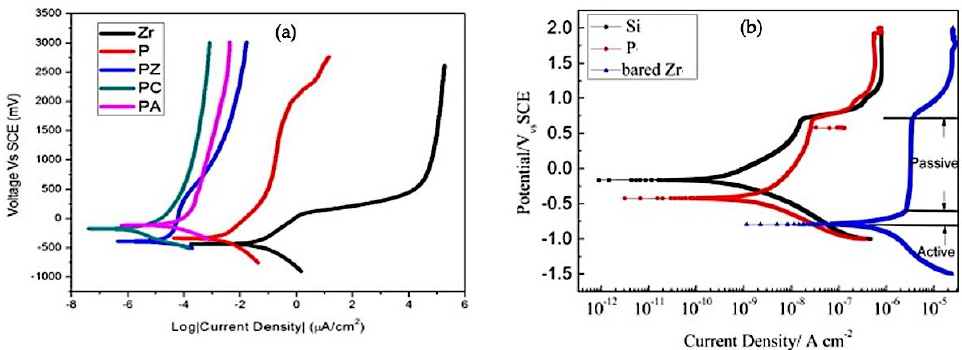
Figure 3. ( a ) PDP plot of Zr substrate, simple PEO coating (P), composite coating of PEO and each of Al 2 O 3 (PA), Ce 2 O 3 (PC), and ZrO 2 (PZ) [9] (Reproduced with permission number: 5043540009057, Elsevier); ( b ) PDP plot of bare zirconium, phosphate (P) and silicate (Si) PEO coatings [59] (Reproduced with permission number: 5043540272527, Elsevier).